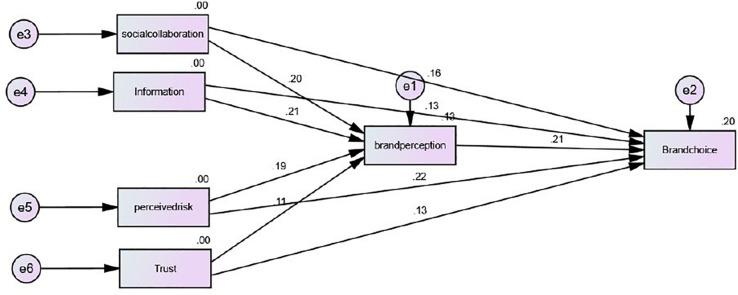
AMOS measurements.